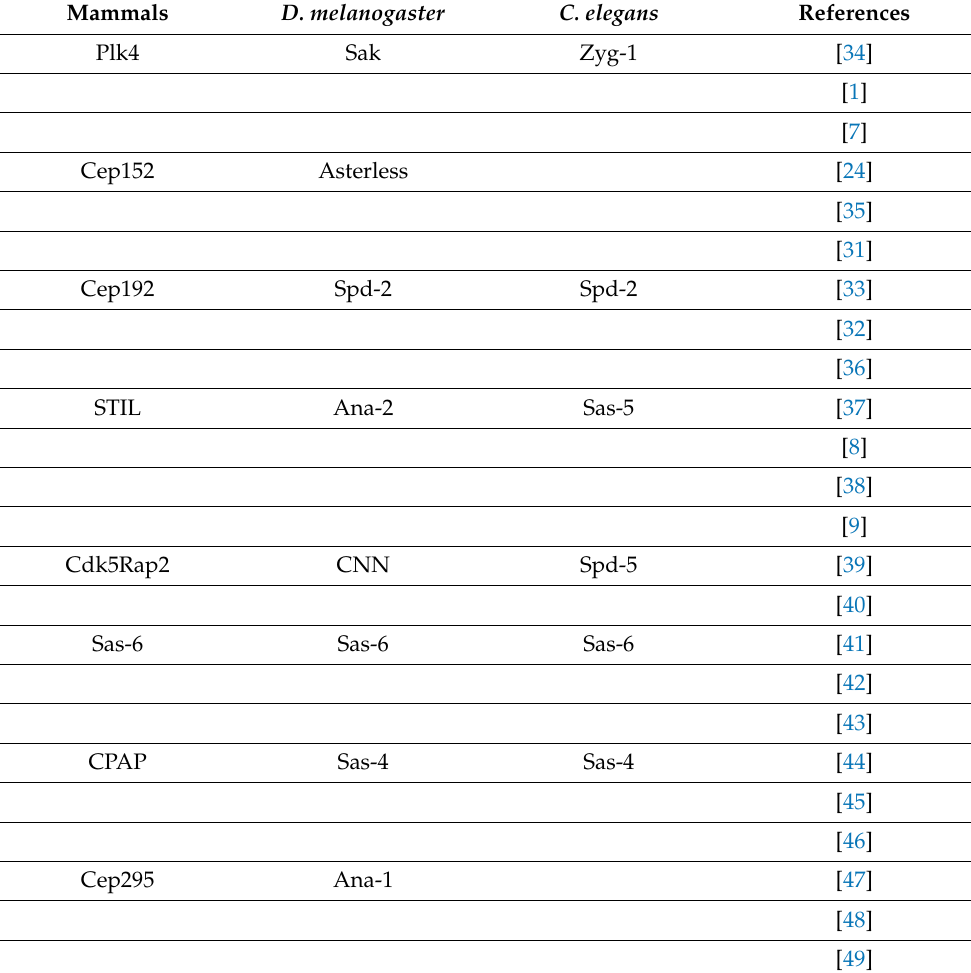
Table 1. Mammalian proteins and their orthologs involved in the early steps of centriole duplica- tion.